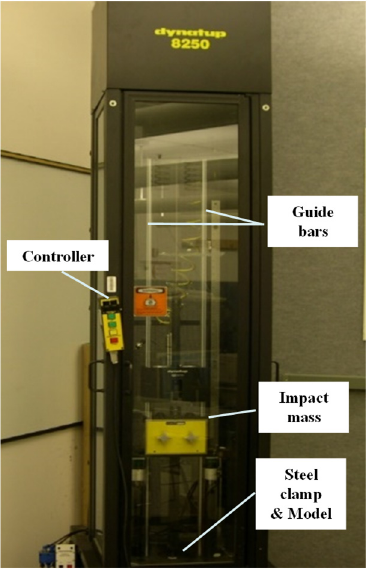
Figure 2. Dynatup model 8250 instrumented drop weight impact tower.